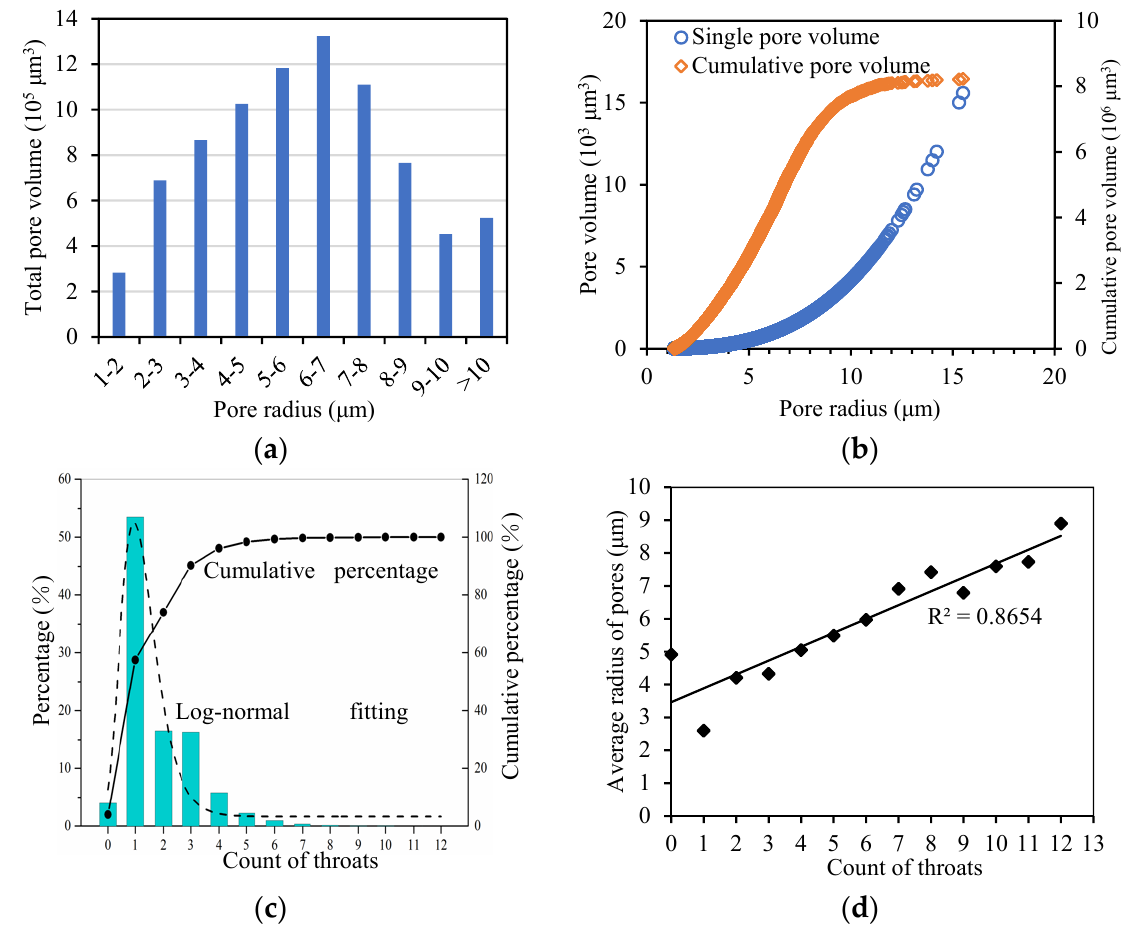
Figure 6. Characteristics of micro–scale pores. ( a ) total pore volume distributions; ( b ) single pore volume distributions and cumulative pore volume distributions; ( c ) pore throat distribution; ( d ) relationship between the size of pores and the number of pore throats.